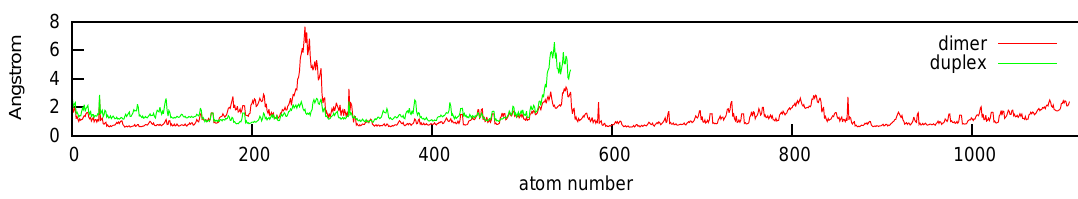
Figure 10. Atomic fluctuation plot shows fraying, the characteristic increase in motion at chain termini as bases periodically separate and then re-pair.